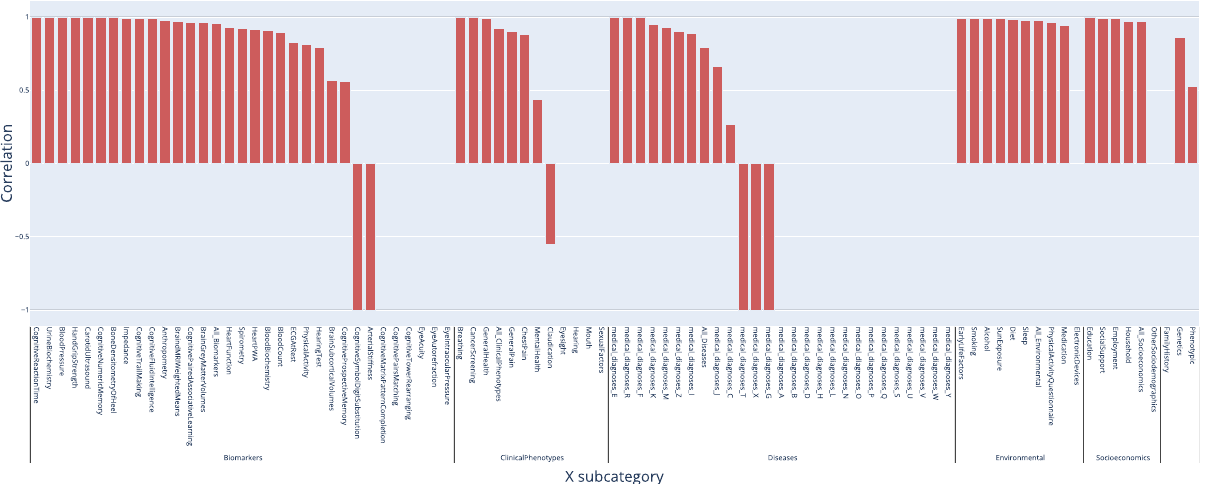
Fig. 6 Correlation, or overlap, of non-genetic associations between Liver and Pancreas Aging. X-Axis denotes the category of non-genetic variable, and the y-axis is the correlation of the association sizes between Pancreas and Liver Aging